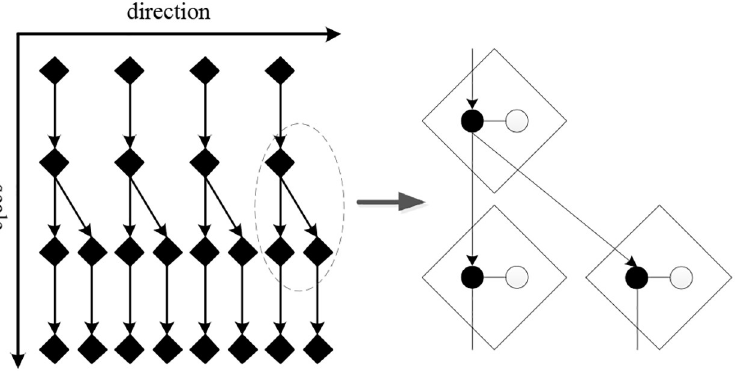
Fig 3. Links of the subbands of a contourlet decomposed by 4,4,8,8 directions at each scale. The hidden states (black circles) are correlated to predict the observation states (white